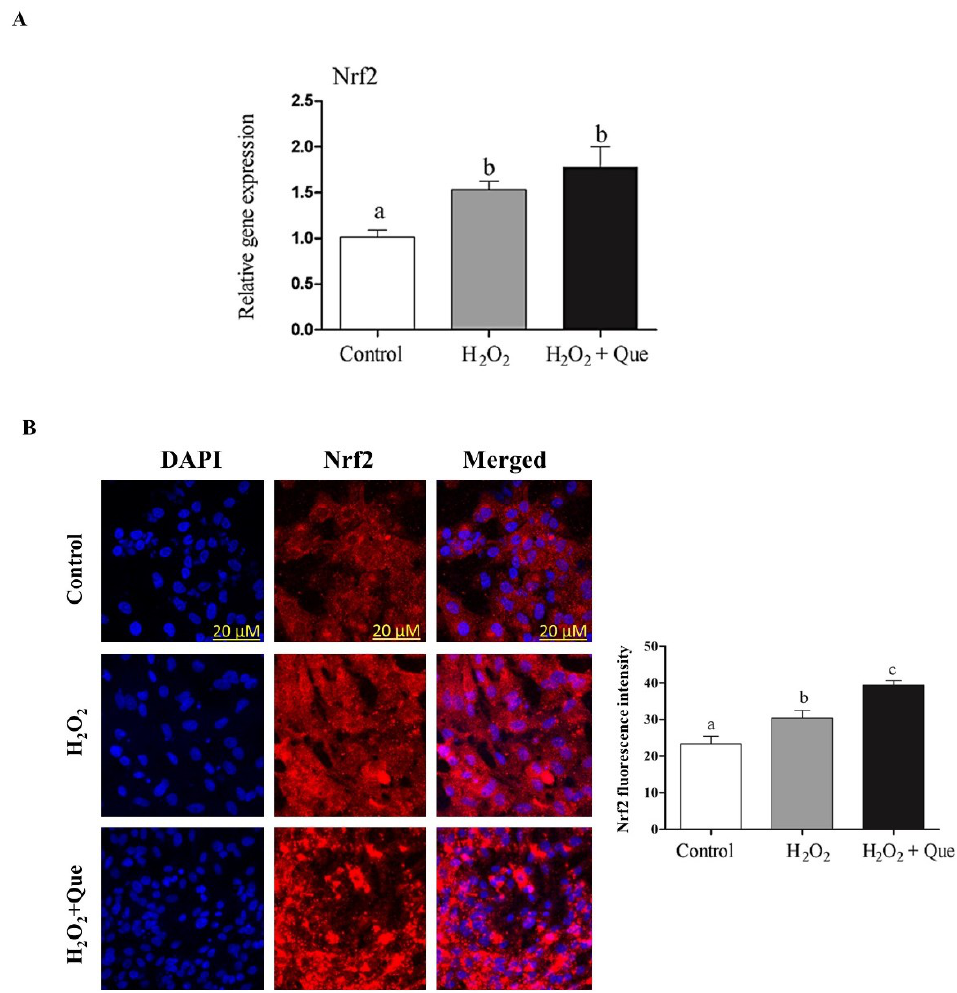
Figure 7. Treatment of cells with quercetin showed slight increment in the expression of Nrf2 under oxidative stress ( A ). Bovine granulosa cells co-incubated with quercetin under oxidative stress condition showed upregulation of Nrf2 at protein level ( B ). The white bar indicates the control group and the gray and black bars indicateH 2 O 2 treated and cells treated with both H 2 O 2 and quercetin, respectively. Data are presented as mean ± SEM of three independent biological replicates. Bars with different letters (a,b,c) showed statistically significant differences ( p ˂ 0.05).